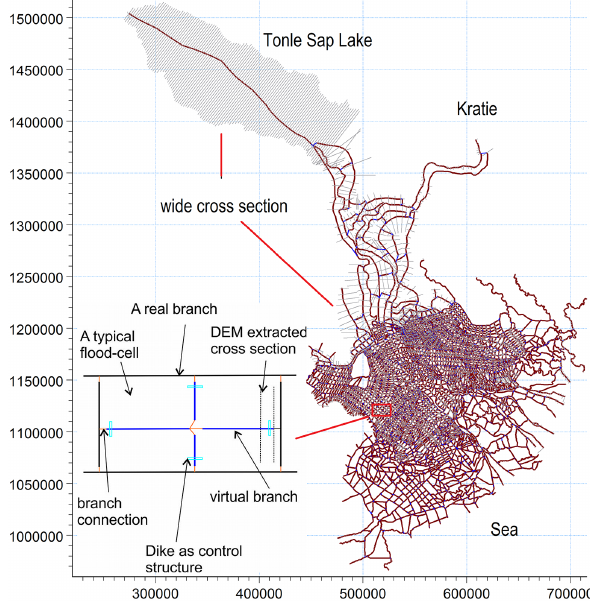
Figure 2. Model river network and quasi-2D concept for a typical floodplain compartment in the